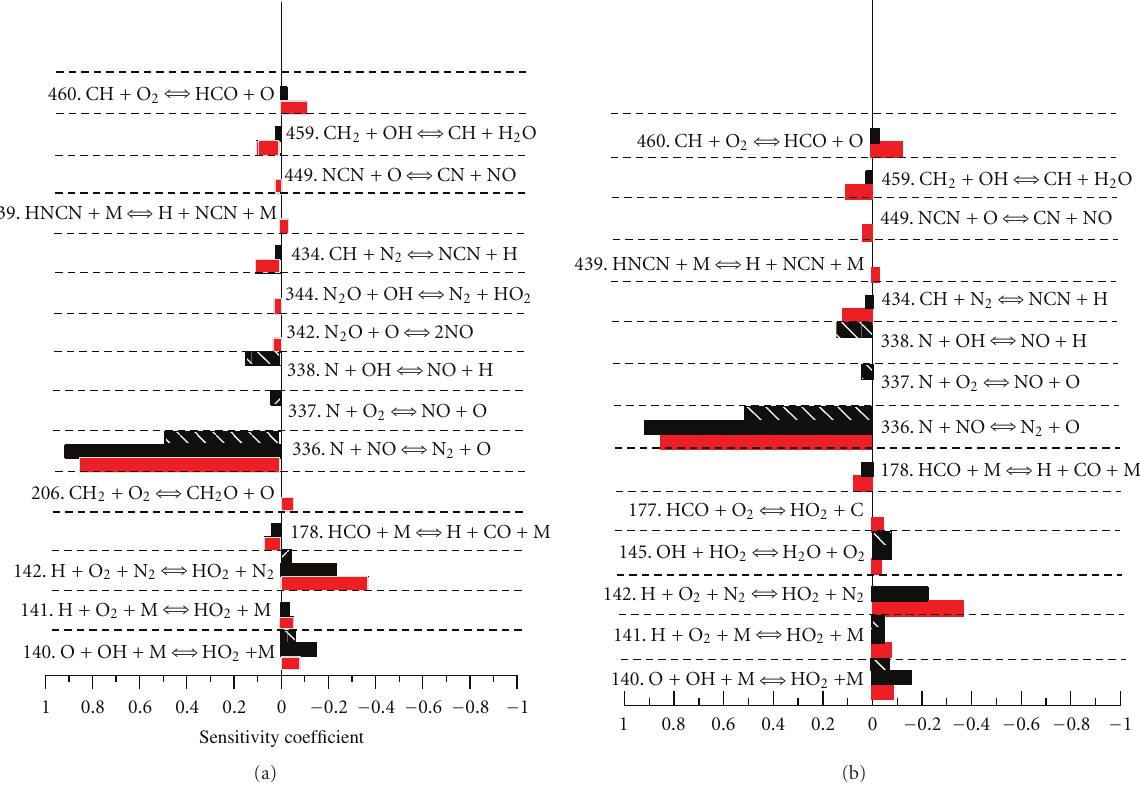
Figure 6: The normalized sensitivity coe ffi cients for NO with respect to the important reaction rates, (a) DOS, (b) RME at di ff erent temperatures (red bars indicate sensitivity coe ffi cients at 1226.84 ◦ C, black bars at 1526.84 ◦ C, and hatched bars at 2026.84 ◦ C).